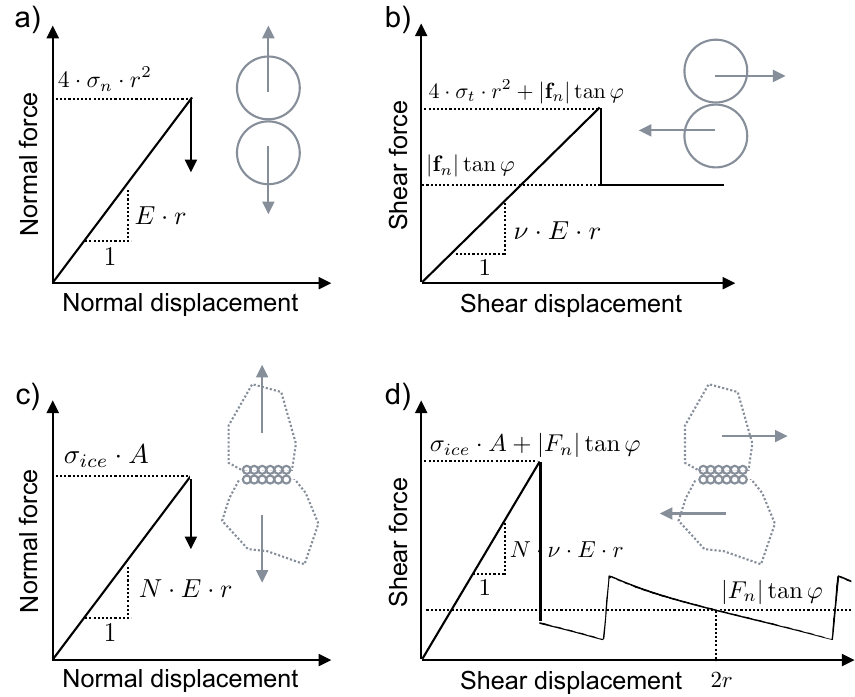
Figure 3. Behavior of a sphere–sphere contact (a, b) and a grain–grain contact (c, d) in two simple cases: normal loading (a, c) and simple shearing (b, d) under constant normal force ( f n , F n ). The grain–grain contact is here composed of seven sphere–sphere contacts. The small spheres have a radius r . The intergranular contact area is denoted A . The number of sphere–sphere interactions in the grain–grain contact is denoted N = A/( 4 r 2 )